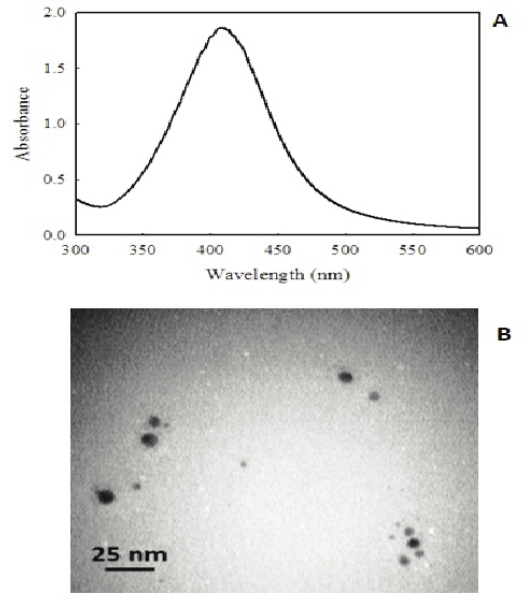
Fig. 2 ­ The SPR spectrum of C. myxa synthesized with the AgNPs (A), and TEM image of AgNPs synthetized by C. myxa leaf extract (B).